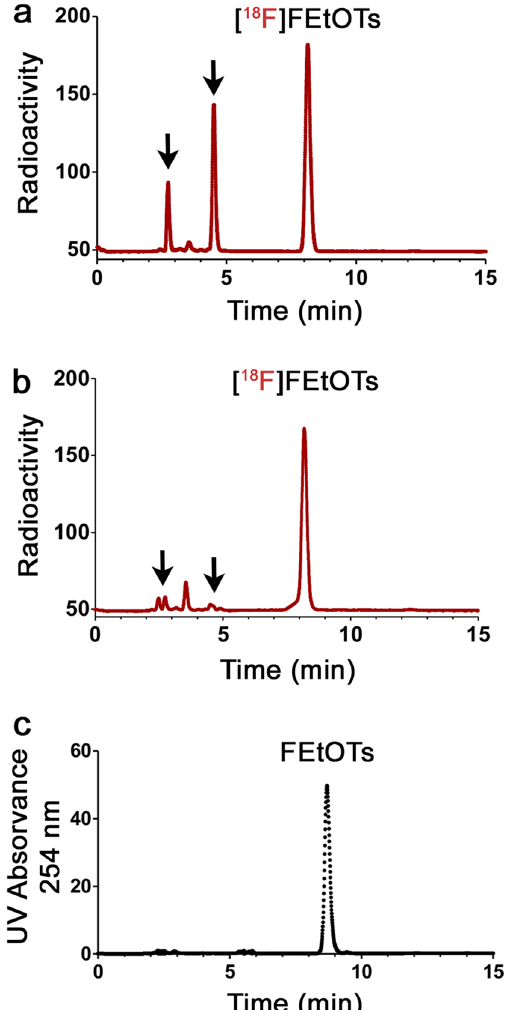
Fig. 2 Radiochromatograms of the crude mixture of [ 18 F]FEtOTs in a sealed ( b ) and unsealed reaction vials, and c chromatogram of the cold reference compound confirming the chemical identity of [ 18 F]FEtOTs after analysis by analytical HPLC. The black arrows indicate the signals of the volatile side-products at 2.7 and 4.7 min on the radiochromatograms. The retention time of the cold reference FEtOTs was 8.7 min. HPLC chromatograms are representative of (n 3) and were performed using an Agilent Zorbax Eclipse Plus C18 = (5 µm, 4.6 250 mm) analytical column; elution with 0.1% TFA water / MeCN, 55:45 at 1 mL/min; monitored × at 254 nm and with a radioactivity